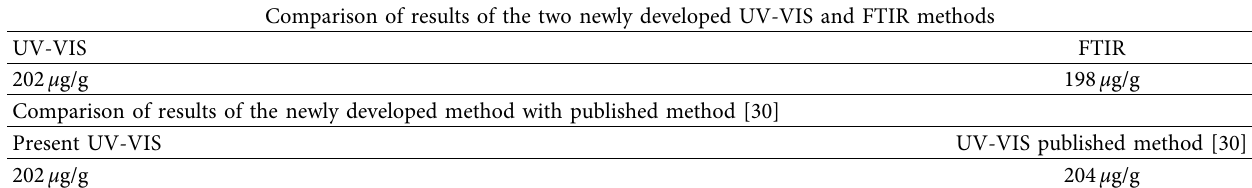
Table 6: β -Carotene content ( µ g/g) of the same pumpkin flesh using different